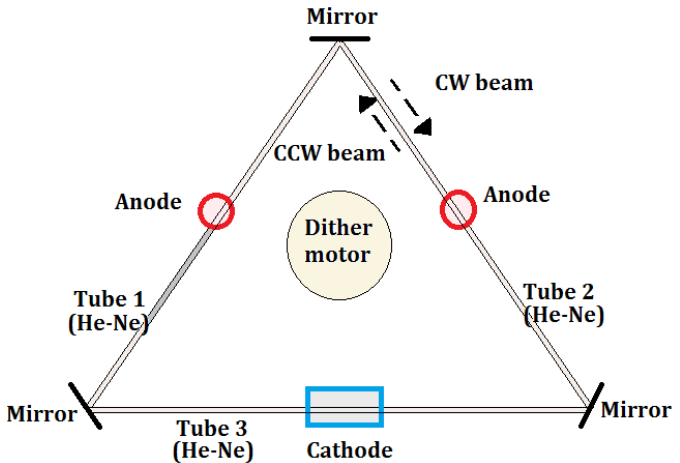
Figure 6. RLG made by a triangular optical resonator.